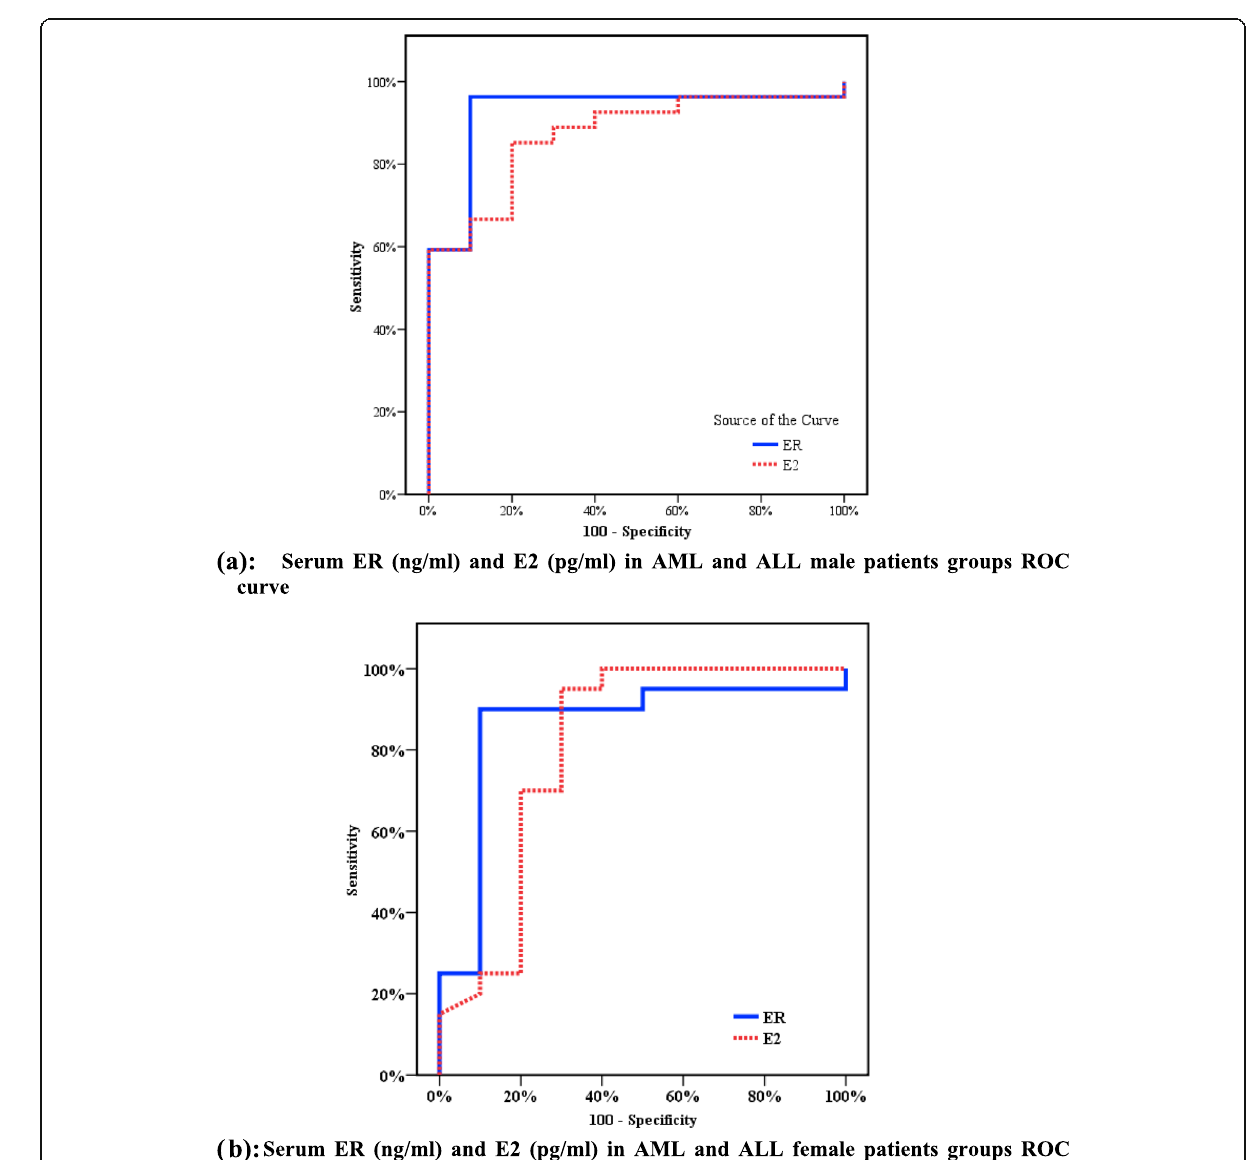
female patients groups ROC